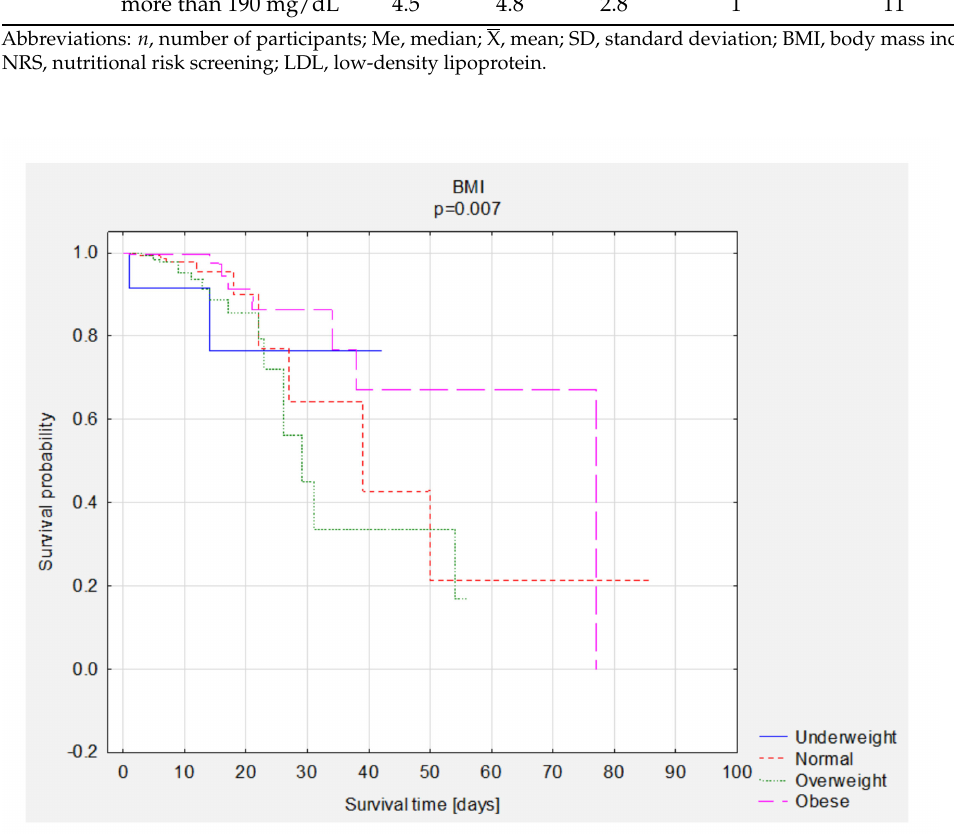
Figure 2. The comparison of survival curves according to BMI results. Abbreviations: BMI, body mass